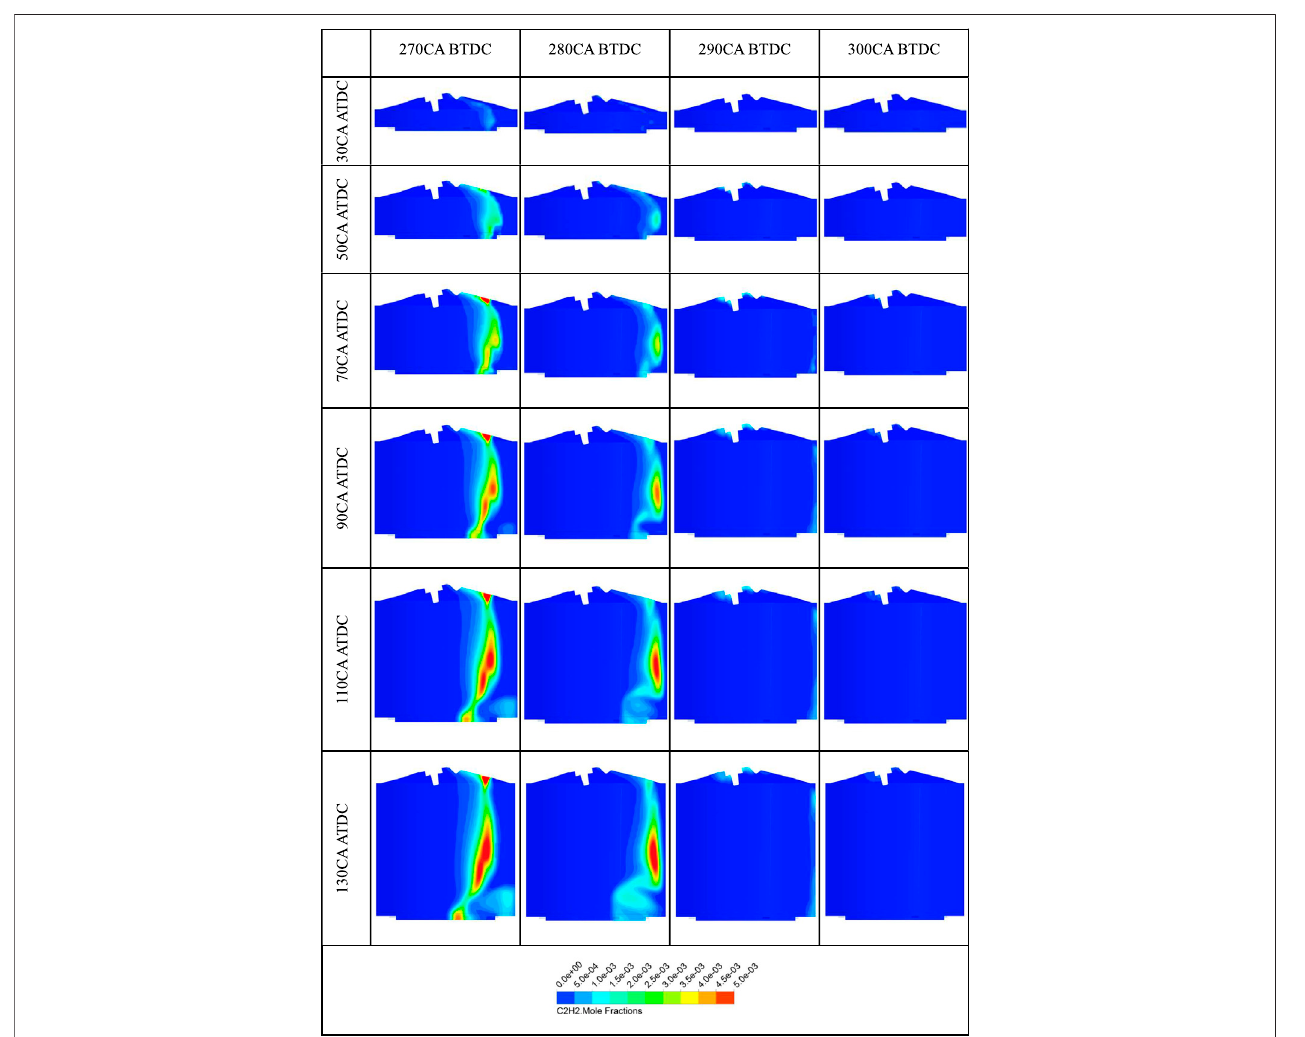
Frontiers in Energy Research |